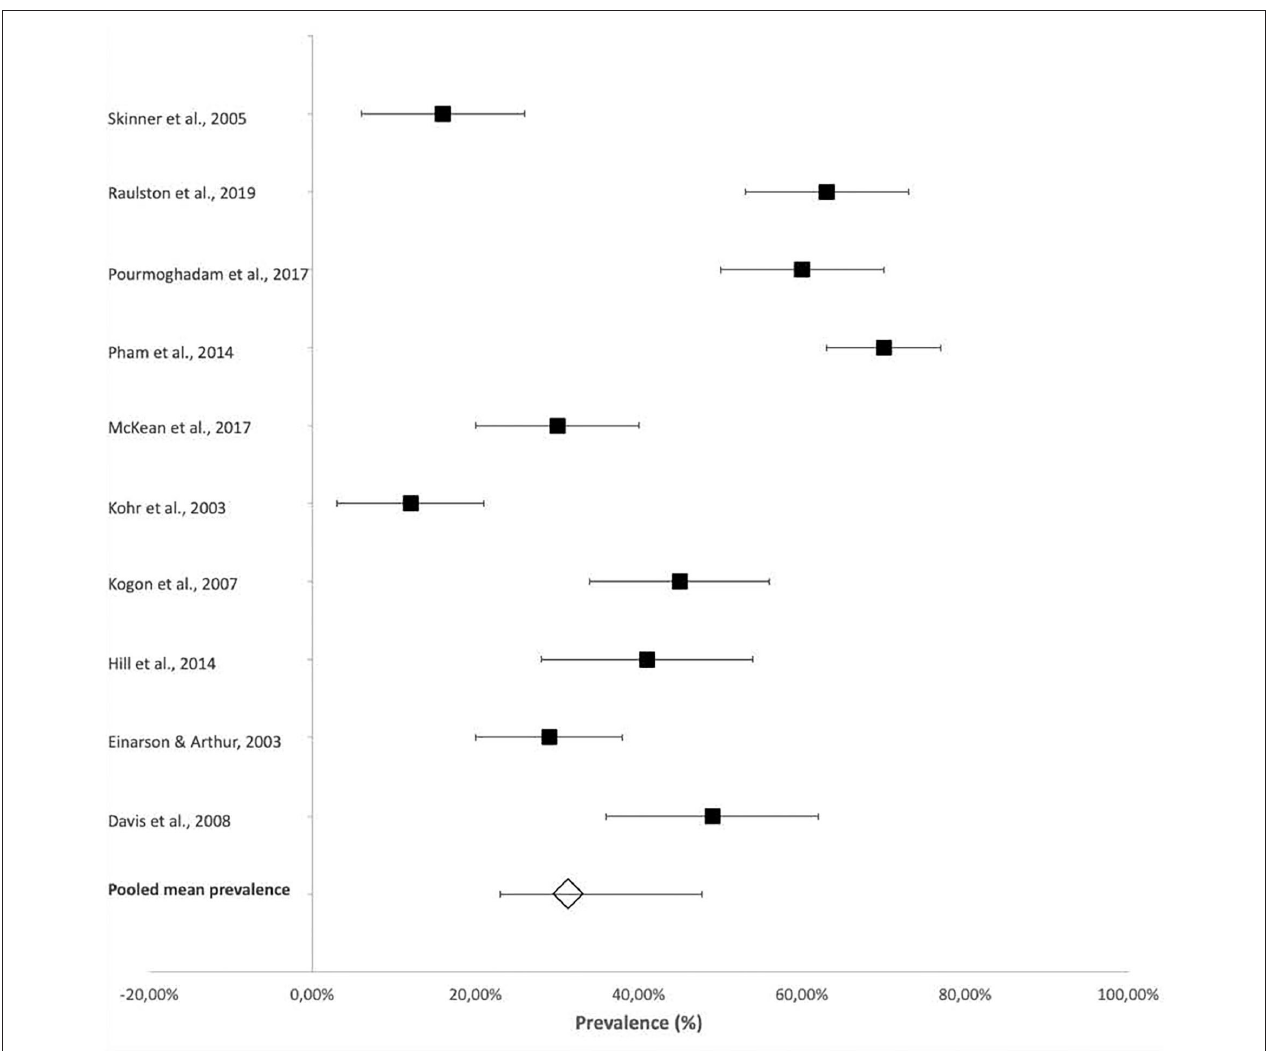
FIGURE 5 | Prevalence of tube feeding reported in infants and children with CHD at and after discharge from hospital.